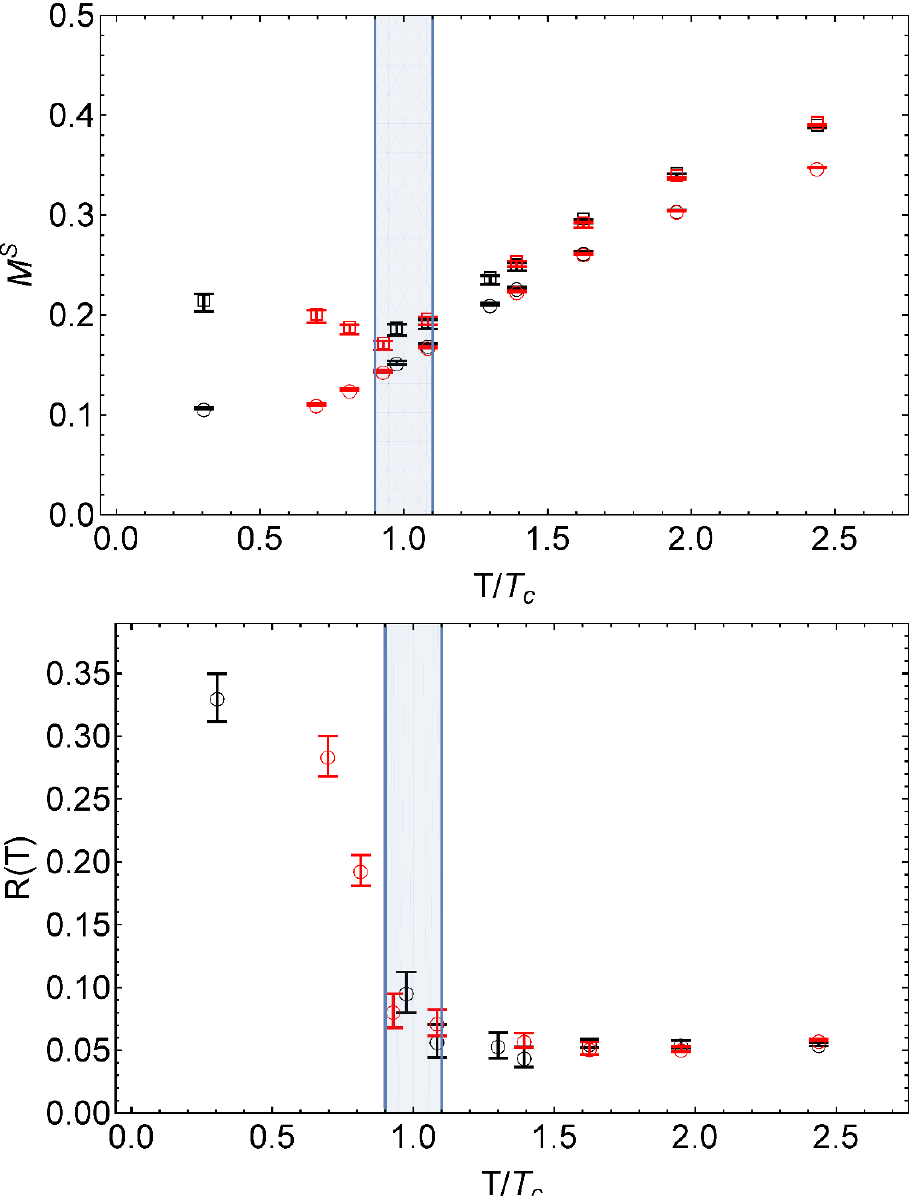
Figure 8 . Screening masses of vectors (circles) and axial vector (squares) mesons (top panel) and the corresponding mass ratio de(cid:12)ned in eq. (4.4) (bottom panel). Black and red points are extracted from ensembles with N t (cid:2) 16 3 and N t (cid:2) 16 2 (cid:2) 24 lattice points, respectively. The temperature is expressed in units of T c . The blue vertical band denotes the uncertainty of T c itself.